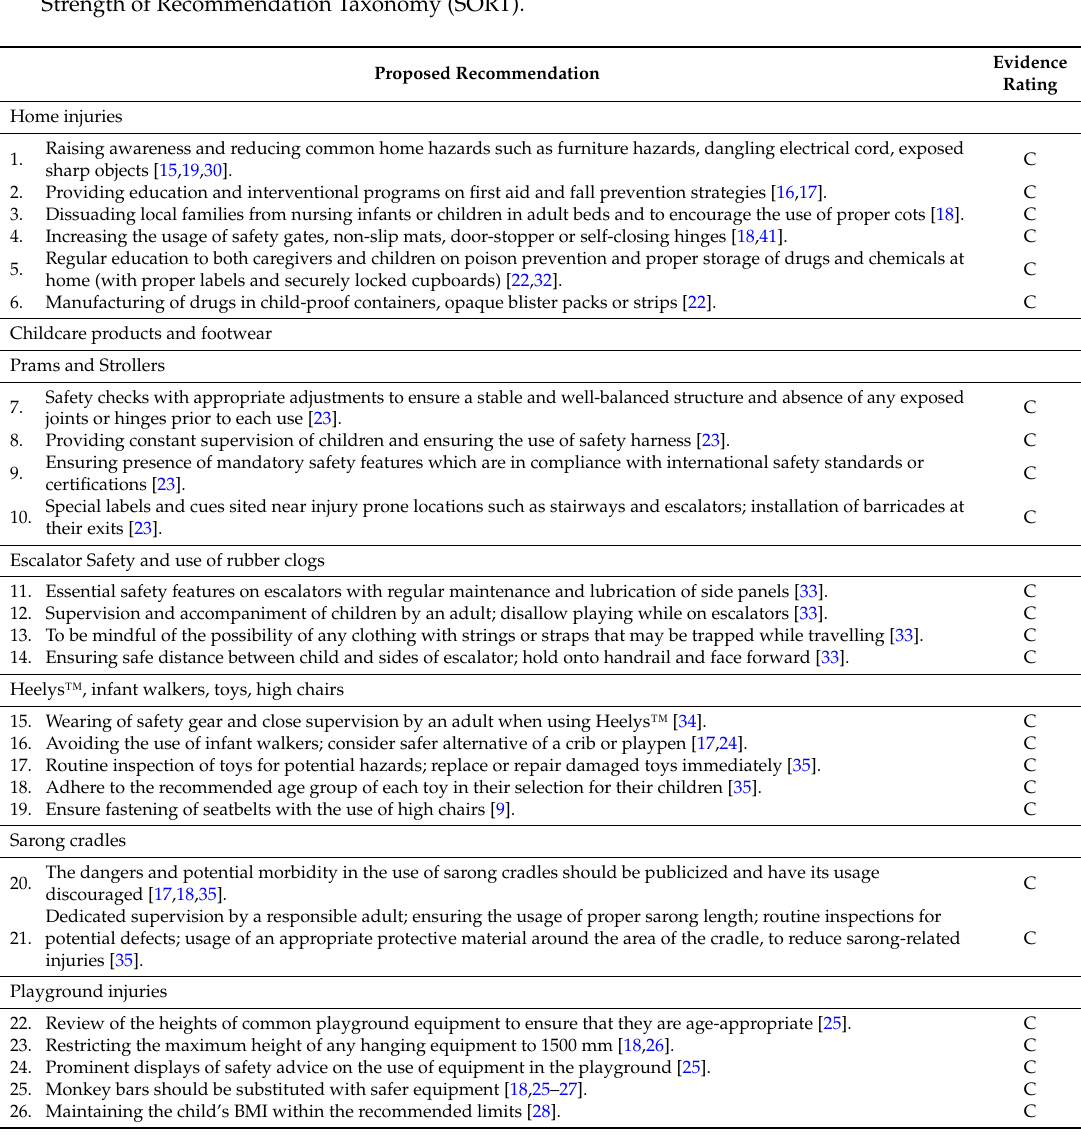
Table 2. Proposed Recommendations in prevention of Childhood injuries in Singapore based on Strength of Recommendation Taxonomy